Question: Give a one-sentence summary of this figure.
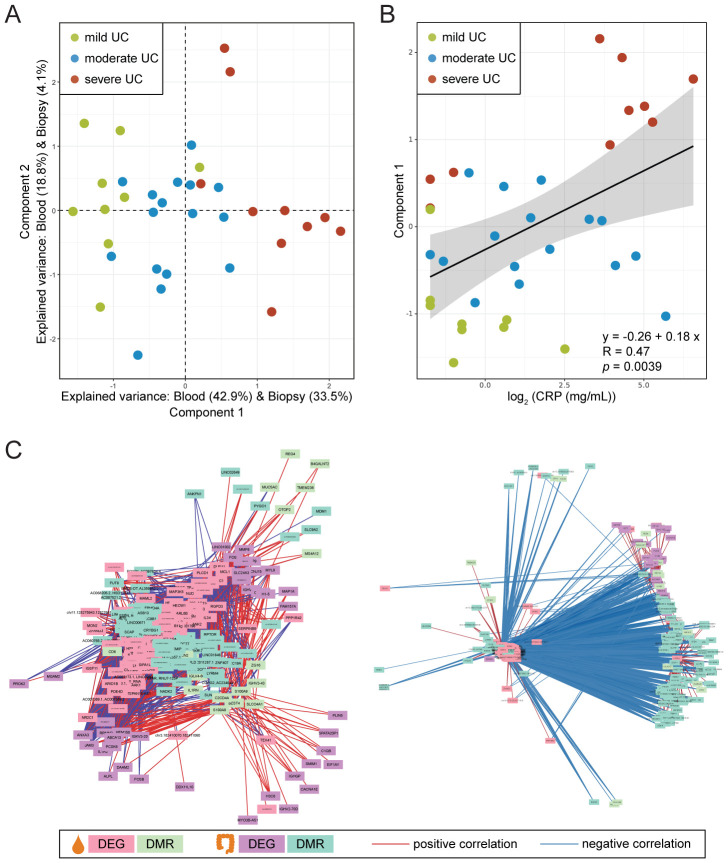
Answer: Regularized canonical correlation integrating gene expression and DNA methylation from blood and tissue. (A) The distribution of patient’s scores in the two-dimensional space delimited by the first two components of the rCCR. (B) Scatter plot of the correlation of component 1 scores (Y axis) vs. log2-transformed CRP concentrations (X axis). The equation of the linear model, as well as Pearson’s coefficient (R) and the p-value were indicated on the bottom-right part. (C) Two different layouts of the network displaying the interactions underlying the canonical correlation model. The network consisted of two different types of interactions: (1) DEG in blood vs. DEG in tissue, (2) DEG in blood vs. DMR in tissue, (3) DMR in blood vs. DEG in tissue and (4) DMR in blood vs. DMR in tissue. Nodes were highlighted as follows: (1) DEG in blood were colored in pink, (2) DEG in tissue were colored in purple, (3) DMR were colored in light green and (4) DMR in tissue were colored in dark green. Red edges represented positive correlations between the two nodes connected, whereas blue edges corresponded to negative correlations between them. Differentially expressed gene (DEG), differentially methylated region (DMR).